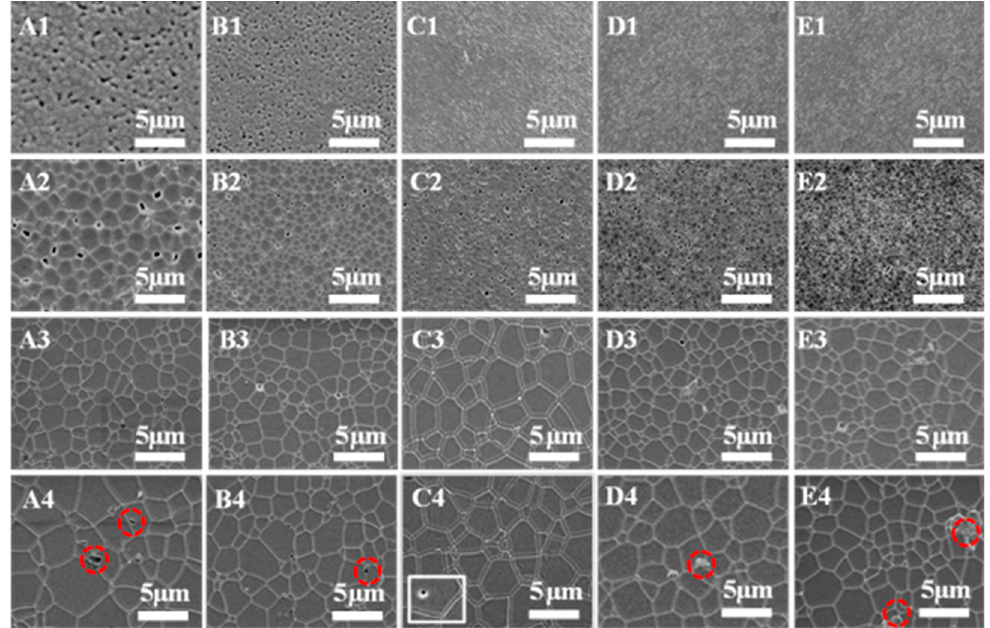
Figure 3. SEM micrographs of the thermal etching surface of different (Tb+Y)/Al ratio samples ( A – E represent 0.5964, 0.6000, 0.6036, 0.6073 and 0.6110) pre-sintered at different temperatures (1 to 4 represent 1350, 1400, 1450, and 1500 °C).